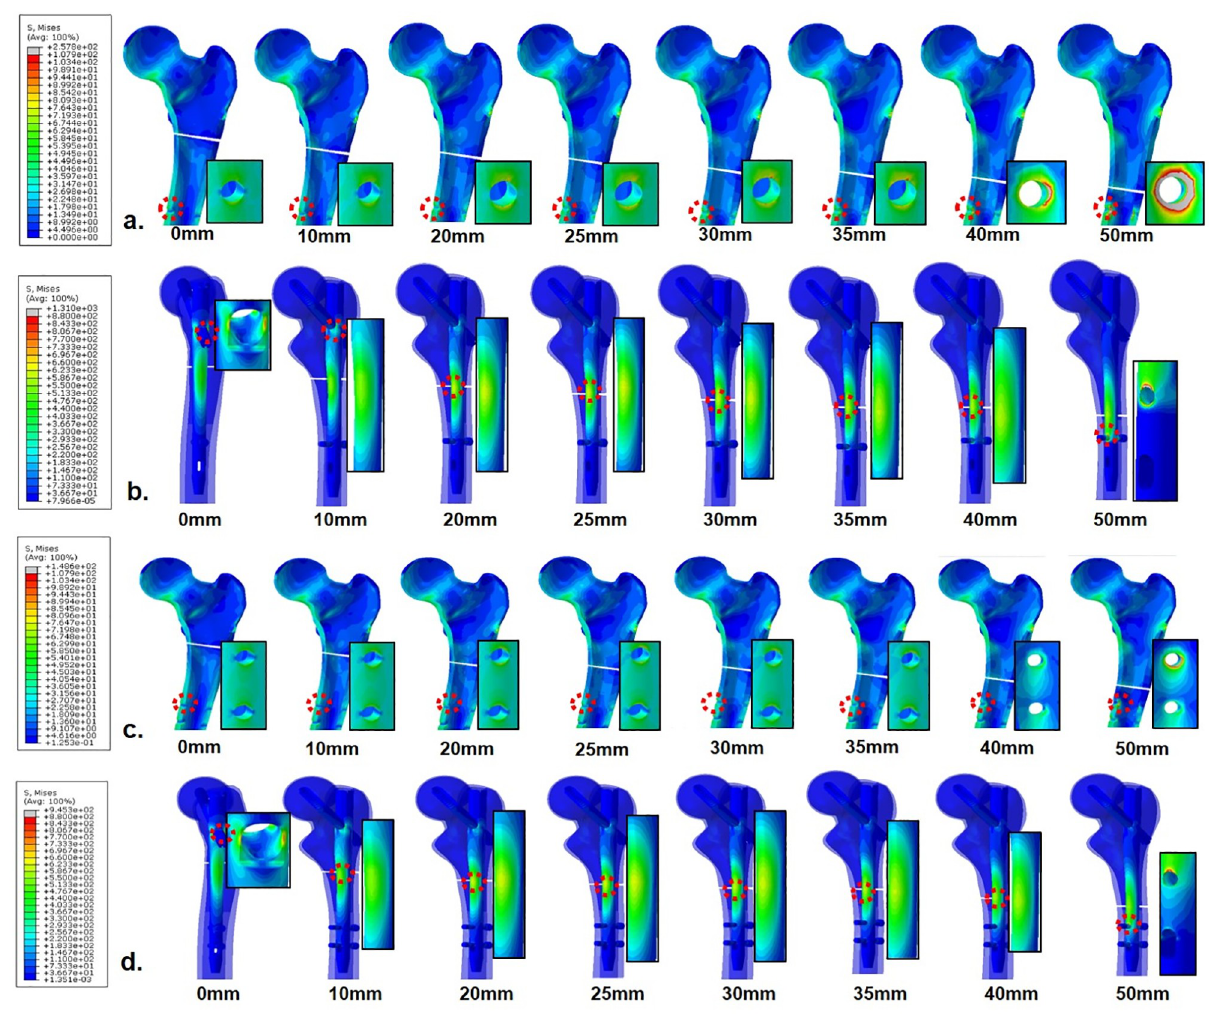
Fig 4. Stress distribution around the cortical bone and implant of finite element models using 1 (a, b) and 2 (c, d) distal screw fixation in 2 mm fracture gap, osteoporotic bone. The enlarged image portion represents the point at which the peak stress was observed.